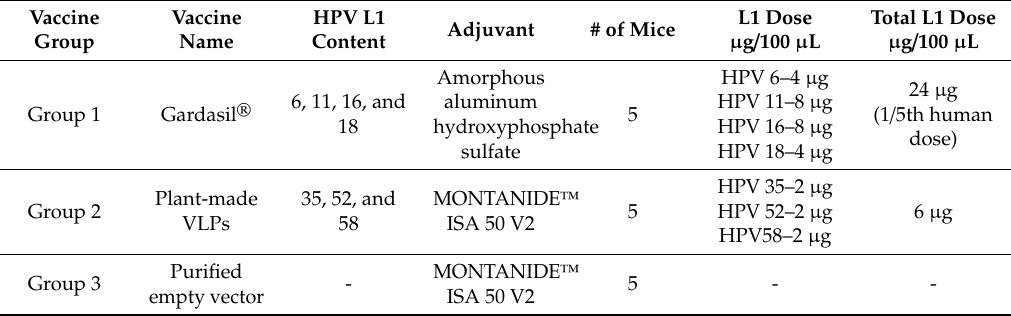
Table 1. Vaccine candidates used to immunize mice in this